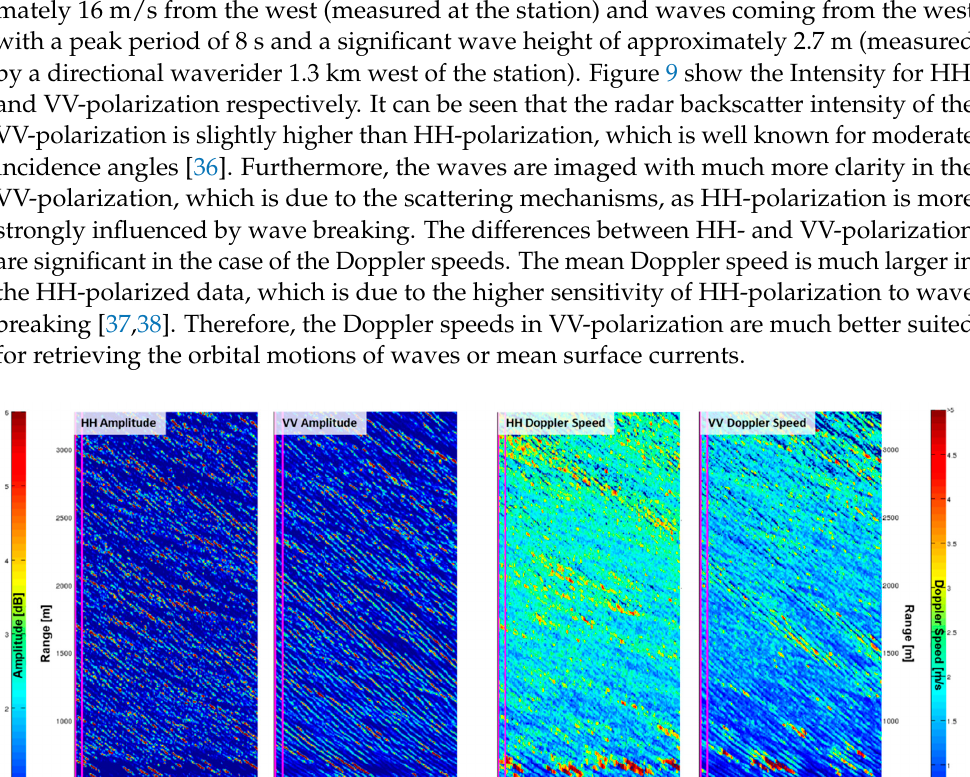
Figure 10. Marine radar measurements of sea ice at VV-polarization in the Fram Strait, acquired from the RV Lance on 3 September 2015 at 14:00 UTC. At the time of acquisition, the vessel was